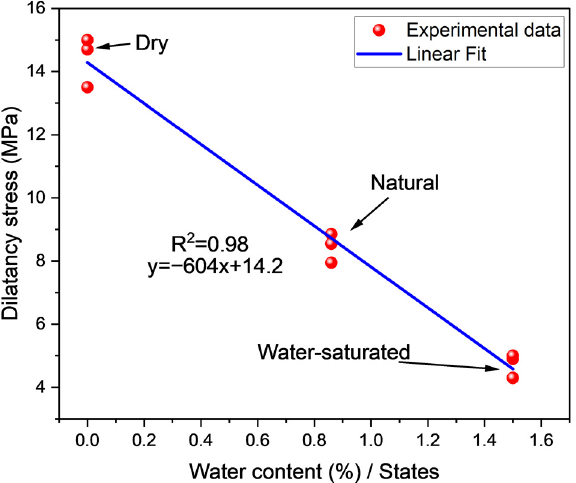
Figure 9. Correlation of different states of coal and crack initiation stress.